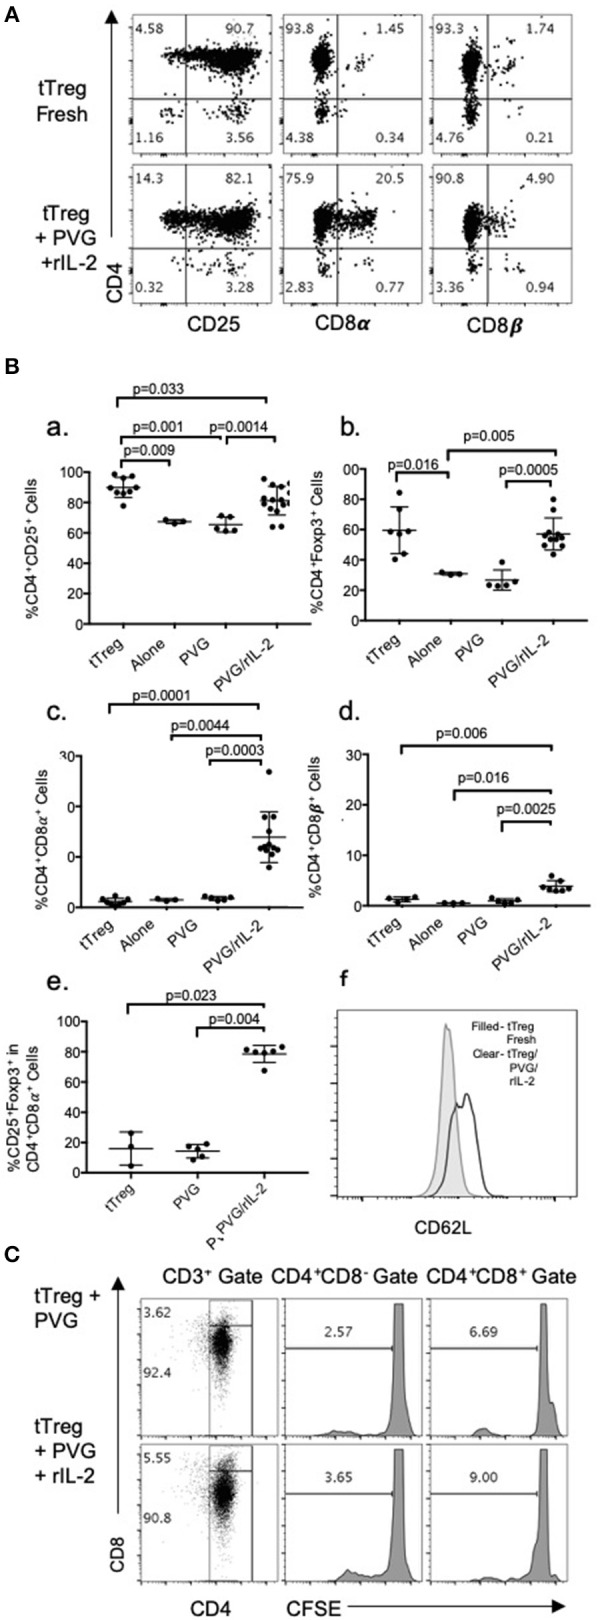
(A) FACS profile of freshly isolated CD4+CD25+T cells (tTreg) from naïve DA rats (Top row) showed >90% cells expressed CD4 and CD25 and <2% expressed either CD8α of CD8β. Bottom row shows tTreg cultured with rIL-2 and PVG alloantigen (Ts1); >80% expressed CD25, about 20% were CD8α+ and 5% CD8β+. This was consistent with expression of CD8α homodimers. (B) Comparison of phenotype of fresh naive tTreg, to these cells after culture for 4 days in medium alone, with PVG alloantigen or with PVG alloantigen and rIL-2. Data from 4 to 5 repeat experiments shown with significant differences if p < 0.05 as determined in a Student t-test. Culture with PVG and rIL-2, preserved the proportion of CD4+CD25+Foxp3+ cells. After culture with media alone or PVG alone there was a reduction in CD4+CD25+cells (a) and CD4+Foxp3+ cells which fell to about 30% (b), consistent with tTreg not surviving without rIL-2. CD4+CD8α+ cells were increased only after culture with PVG and rIL-2 and represented 10–20% of cells (c), whereas there was a lesser increase in CD4+CD8β+T cells (d). Thus, there was mainly induction of CD8α homodimer and less CD8αβ heterodimer. The CD4+CD8α+T cells were mainly CD4+Foxp3+ cells (e) suggesting they were regulatory T cells. (f) Compared to fresh naïve tTreg the expression of CD62L increased after their culture with rIL-2 and alloantigen (Data representative of 4 experiments). (C) tTreg proliferation with rIL-2 and alloantigen: Freshly isolated naïve DA CD4+CD25+T cells were labeled with CFSE and cultured for 4 days with PVG alone or in presence of rIL-2. Cells were stained with CD4/CD8α/CD3 mAb and gated as CD4+CD8− or CD4+CD8α+. CFSE dilution assessed on a FACS Canto showed proliferation was greater in the CD8α+ cells.